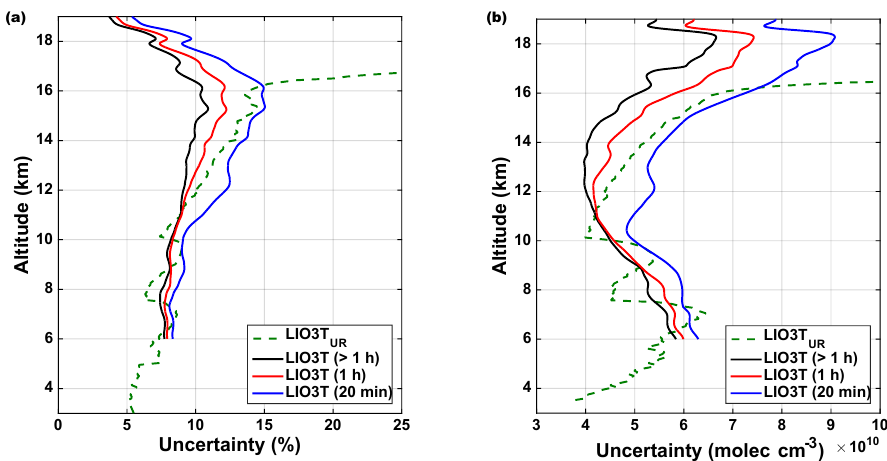
Figure 4. Mean uncertainties in % (a) and moleccm − 3 (b) of the LIO3T UR profiles (dashed green curve) and LIO3T profiles for integration times greater than 1h (black curve), equal to 1h (red curve) and equal to 20min (blue